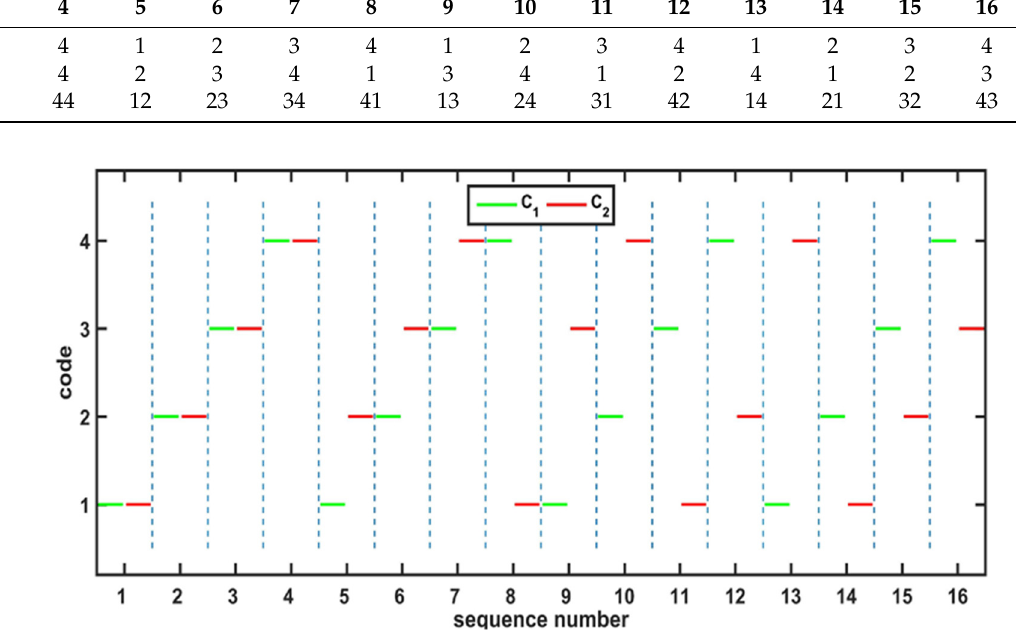
Figure 1. The designed codewords of the proposed method.